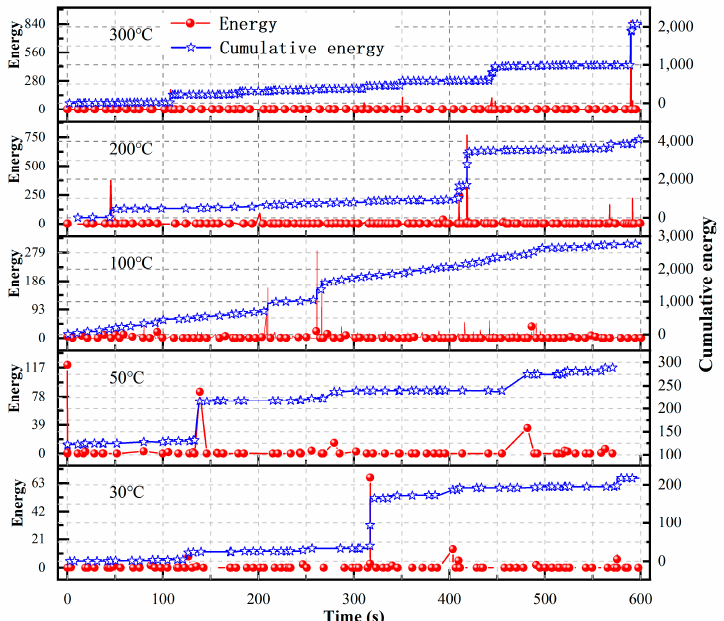
Figure 5. 600 s AE energy map of different temperature stages in the process of coal spontaneous combustion.